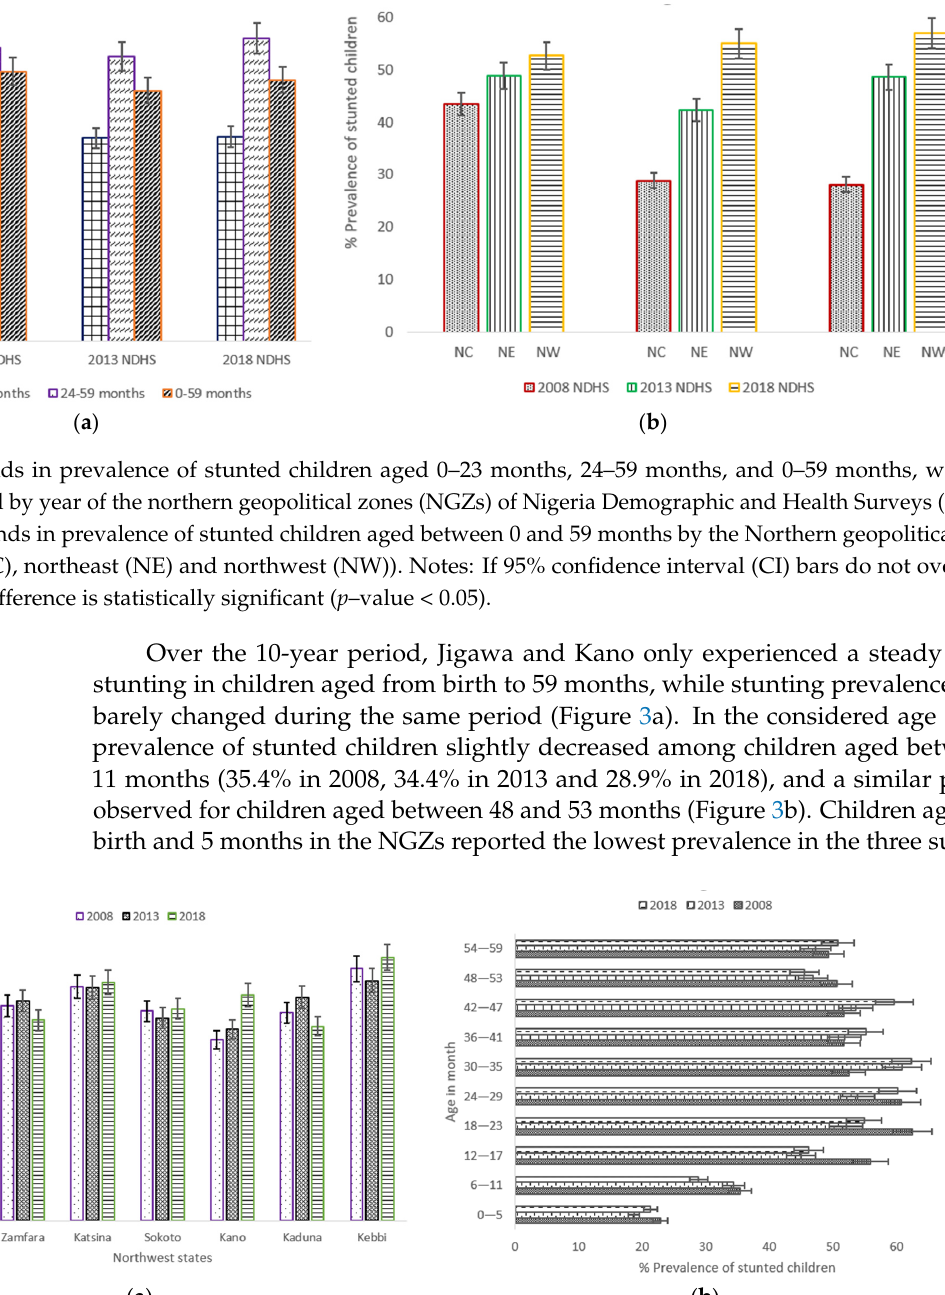
Figure 1. The overall prevalence of stunted children between 2008 and 2018 in the NGZs by age in